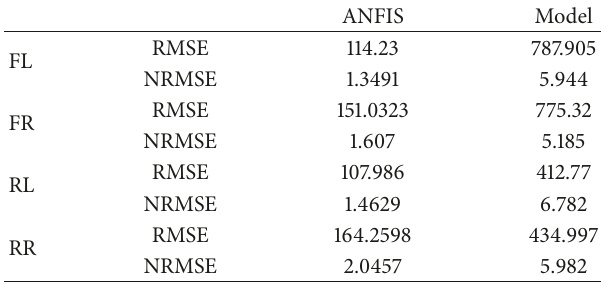
Table 7: Skid-pad results. Table 8: Double lane change